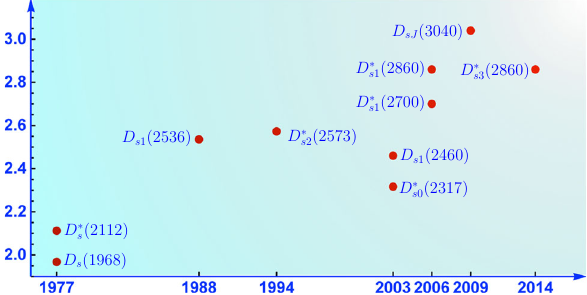
Fig. 1 The history of charmed-strange meson discovery [1–5,24,28]. Here, the masses of the charmed-mesons are taken from the Review of Particle Physics [35] Table 1 Experimental information of the radiative transitions between charmed mesons Initial